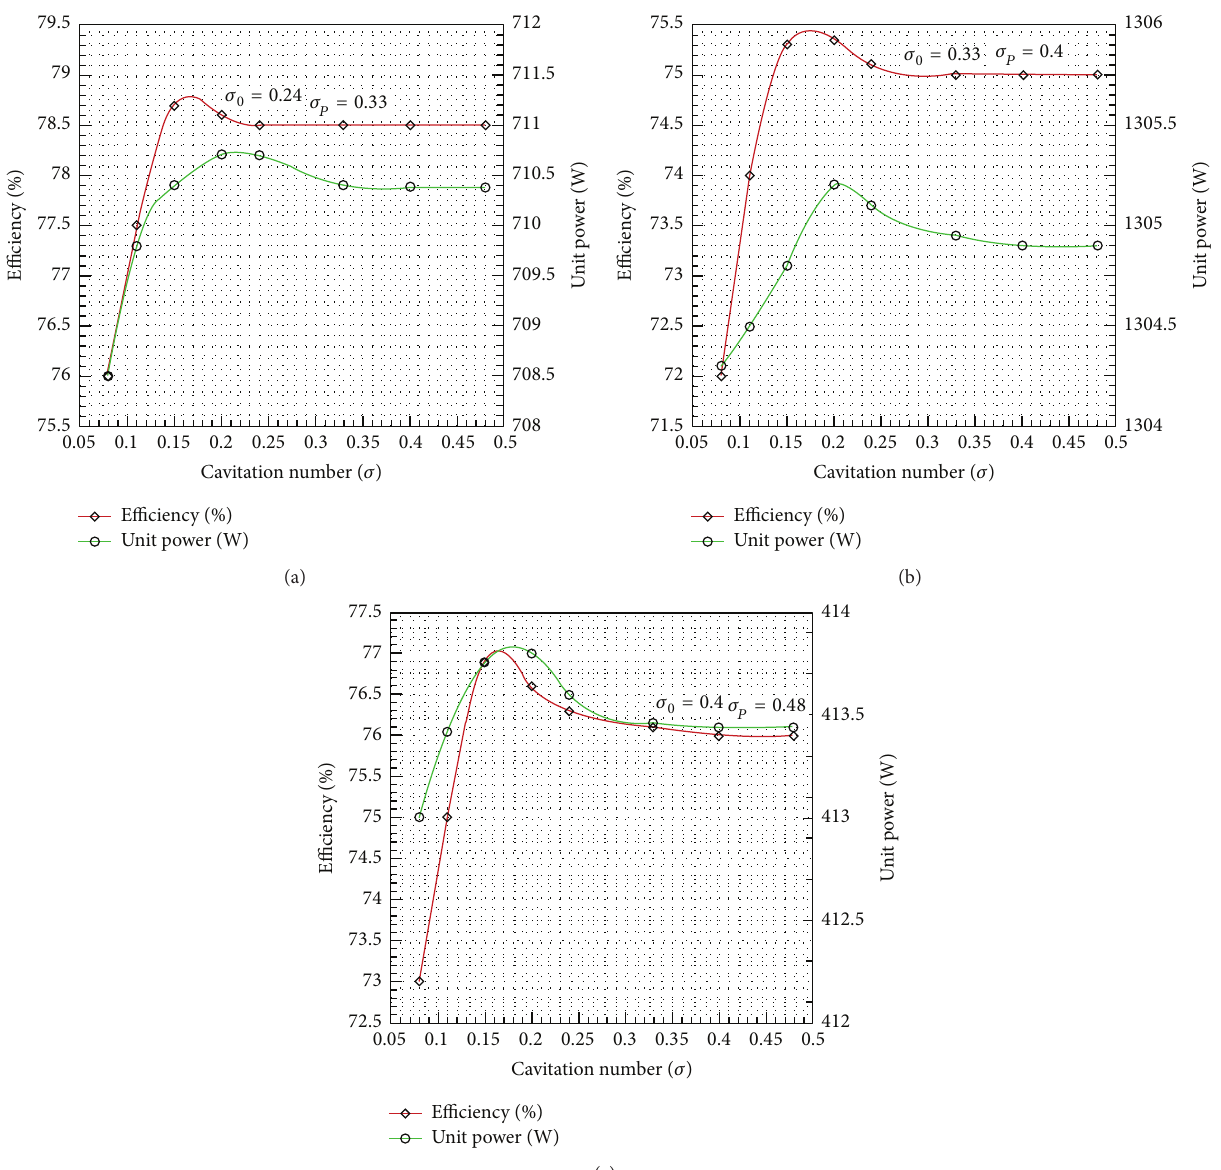
Figure 17: Cavitation effects on hydraulic efficiency and unit power: (a) at optimal point (BEP), (b) at large flow rate, and (c) at small flow